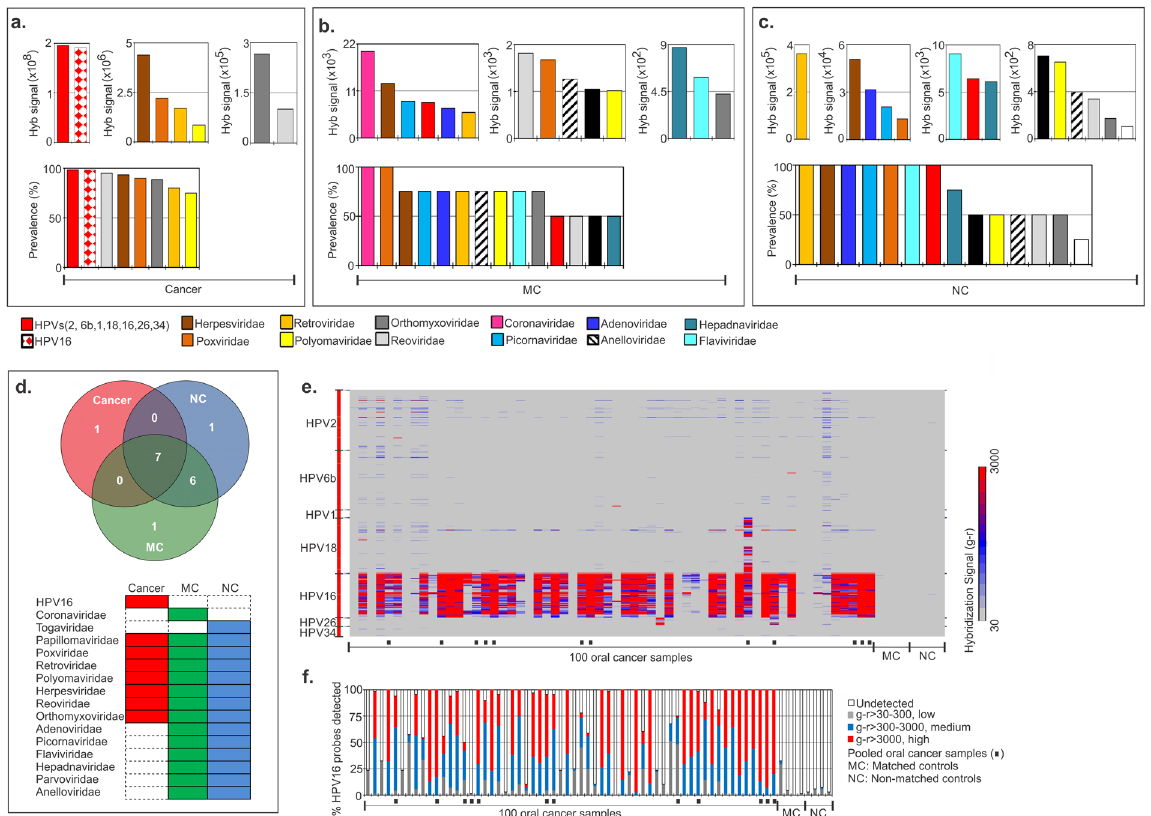
Figure 1. Viral signatures detected in oral cancer and control samples. ( a ) The viral signatures that are detected with hybridization signal (g–r > 30) by PathoChip screen of 100 oral cancer samples are shown and ranked according to decreasing hybridization signal (weighted score sum of all the probes per accession) and prevalence. ( b and c ) Figure b and c shows the hybridization signals and prevalence for the viral signatures detected in matched (MC) and non-matched (NC) controls respectively, ranked in descending order. ( d ) Figure d shows the association of different molecular signatures of viral families with cancer and controls, represented as a venn diagram, and as colored bars. ( e ) Figure e shows the heat map of hybridization signals detected by PathoChip screen of the HPV probes (Y-axis) with the oral cancer and control samples (x-axis). The hybridization signals of the cancer samples to each of these probes were compared to MCs and NCs. Samples were screened individually or in pools (marked with a ▪ ). ( f ) Figure f shows percentage of HPV16 probes detected with low (g-r > 30–300), medium (g–r > 300–3000) and high (g–r > 3000) hybridization signal in 100 oral cancer samples screened individually and in pools ( ▪ ) and 20 each of MCs and NCs screened in pools of